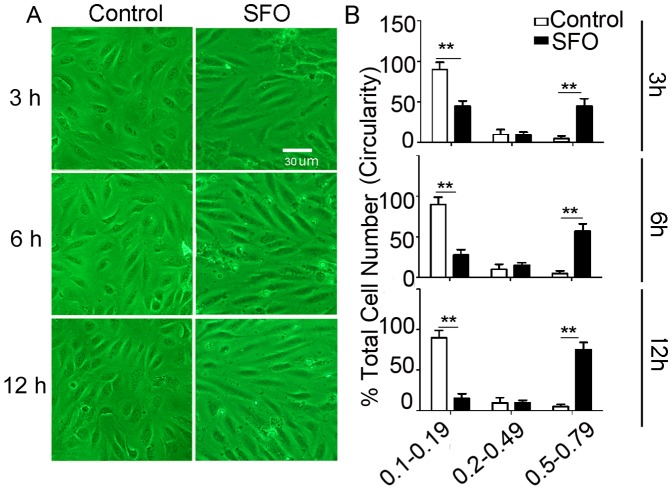
Phase-contrast photomicrographs (A) and morphometric analyses (B) of human umbilical vascular endothelial cells (HUVECs).HUVECs were cultured in normal medium without or with 50 µg/ml safrole oxide (SFO) for 3, 6 and 12 h. (A) Cells in the control group retained cobblestone features, whereas cells cultured with SFO had elongated features and were arranged into “streamlined” structures. (B) Cell circularity, where a circle equals 0 and increasing elongation approaches 1, was calculated after SFO treatment (**p<0.01, n = 5).